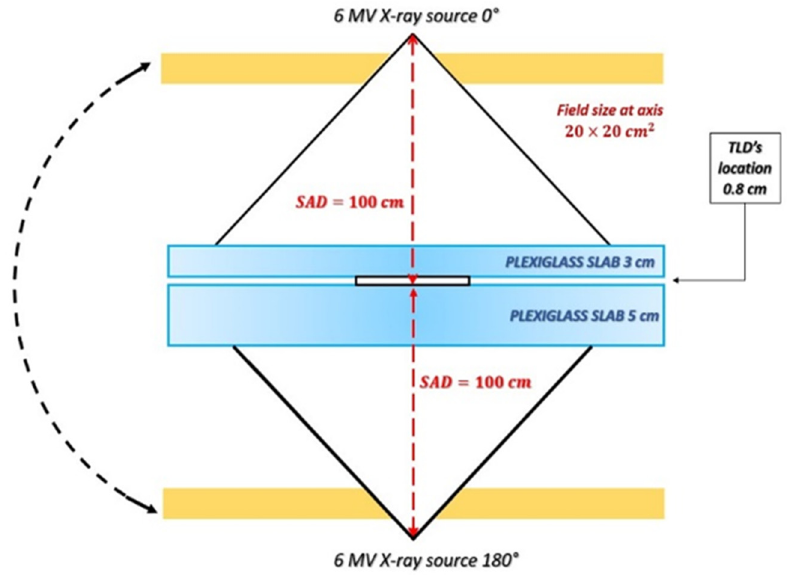
Figure 1. Irradiation set-up to 6 MV photons. Plexiglass slabs of 3 and 5 cm thickness were added to take into account the build-up phenomenon and backscatter radiation to deliver a uniform dose to targets. TLDs were put into a water-equivalent dish of 0.8 cm thickness. The radiation field was a photon beam with the size of 20 × 20 cm 2 at a Source-to-Axis Distance SAD = 100 cm.